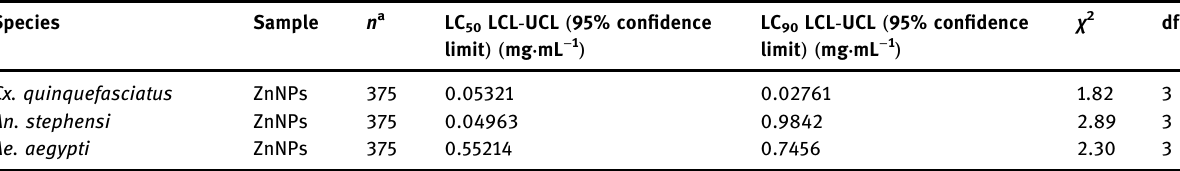
Table 5: Larvicidal activity of C. baccifera ZnNPS against fourth instar larvae of three mosquitoes Species Sample